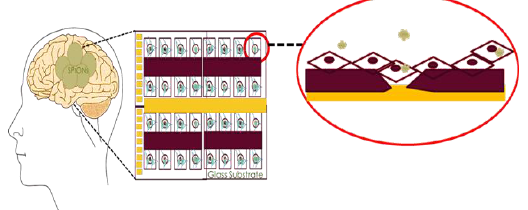
Figure 1. Schematic representation of the interaction of the brain cells with SPIONs when studied in in-vitro using an impedance-based assay. in-vitro using an impedance-based